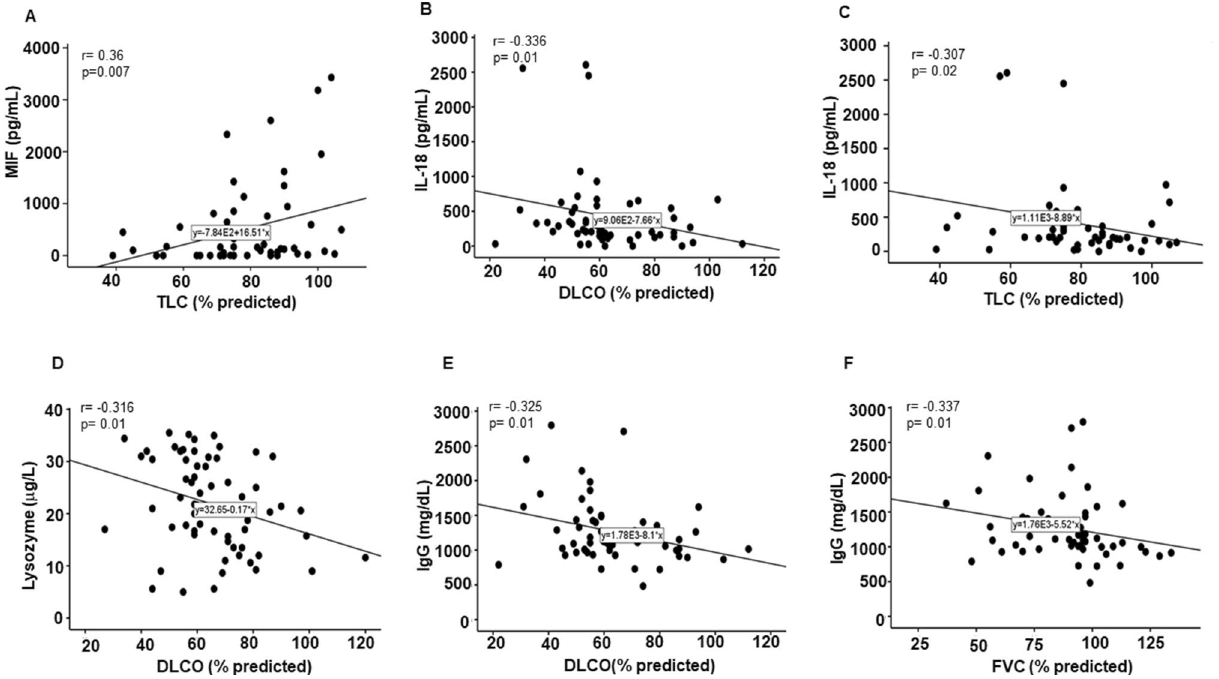
Figure 4. Correlation of serum cytokines and follow up PFT values in sarcoid patients. A correlation scatterplot depicts a positive association of MIF serum levels with %predicted TLC (r = 0.36, p = 0.007) ( A ). A correlation scatterplot of IL-18 showed a negative correlation with %DLCO (r = − 0.336, p = 0.01) ( B ); and %TLC (r = − 0.307, p = 0.02) ( C ). A correlation scatterplot of lysozyme displayed a significant negative correlation with %DLCO (r = − 0.316, p = 0.01) ( D ). A correlation scatterplot of serum IgG levels displayed a significant negative correlation with %DLCO (r = − 0.325, p = 0.01) and ( F ) with %FVC (r = − 0.337, p = 0.01) ( E ). p value < 0.05 was considered to be